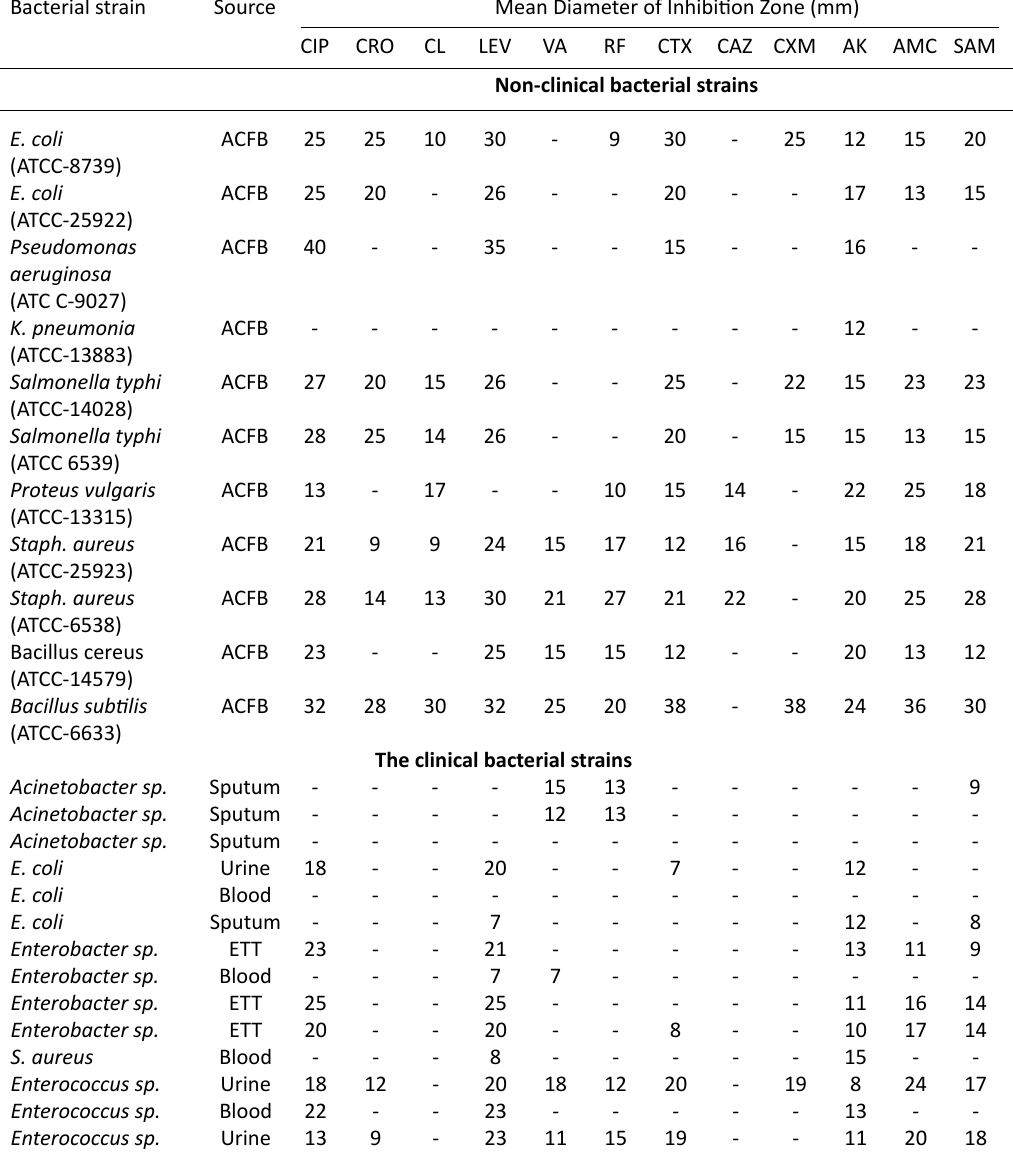
Table 3. Susceptibility of the investigated bacterial strains to different antibacterial discs Bacterial strain